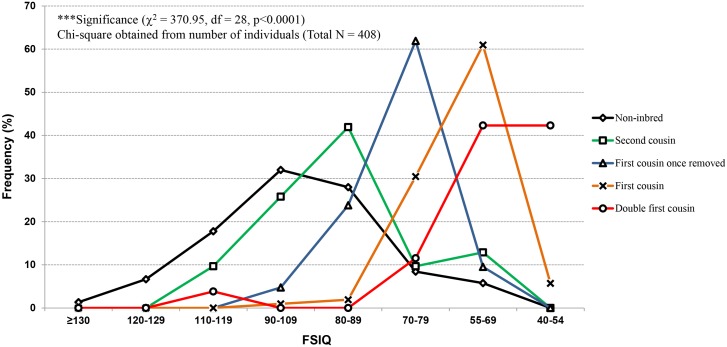
FSIQ comparisons in respect to the degree of inbreeding.The results depict the percentage frequency distribution of FSIQ in relation to coefficient of inbreeding. The non-inbred children display high frequency peaks on left side (presenting high FSIQ values) and downturn toward low FSIQ scores. On the other hand, elevated peaks are observed for low FSIQ scores (on right side) with the increase of inbreeding coefficient (F = 0.0156 to 0.125) and flattened toward high FSIQ scores, providing the evidence for inbreeding depression on children FSIQ.